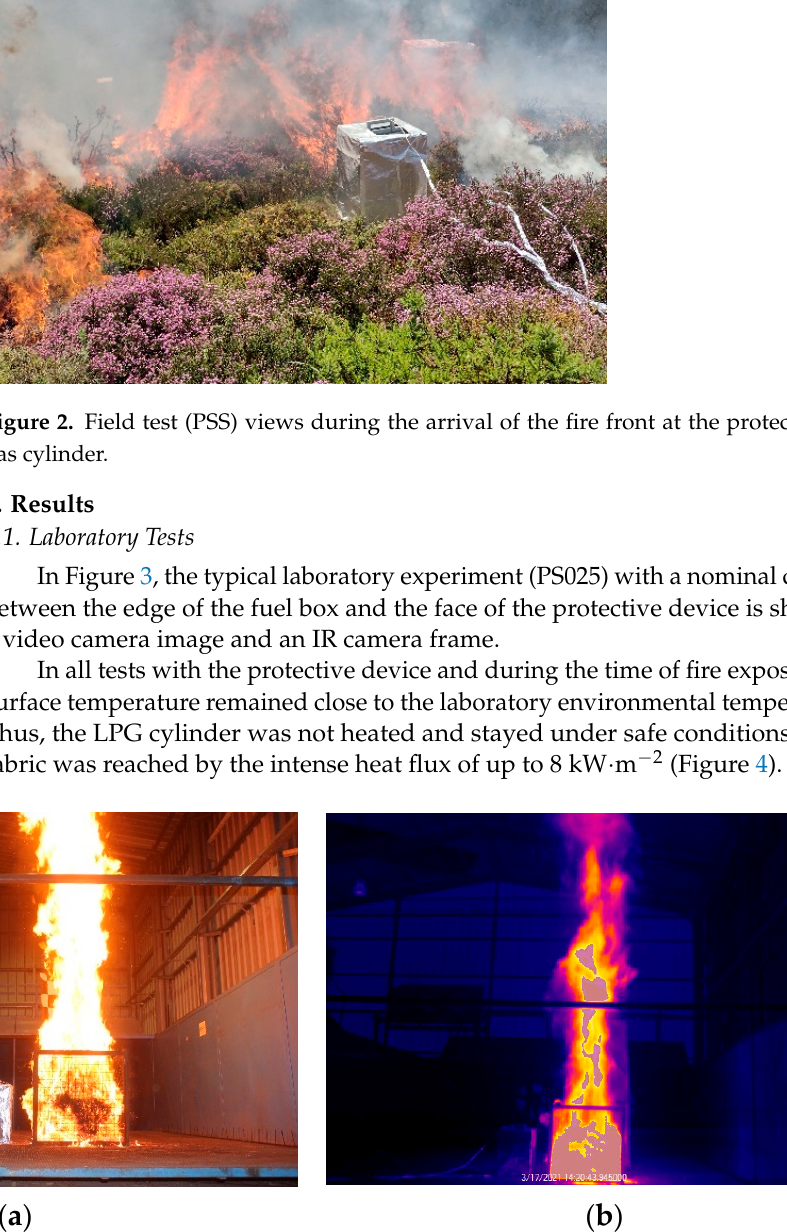
Figure 3. Laboratory test (PS025) at 0.25 m from the basket fuel: ( a ) video and ( b ) InfraRed camera image.